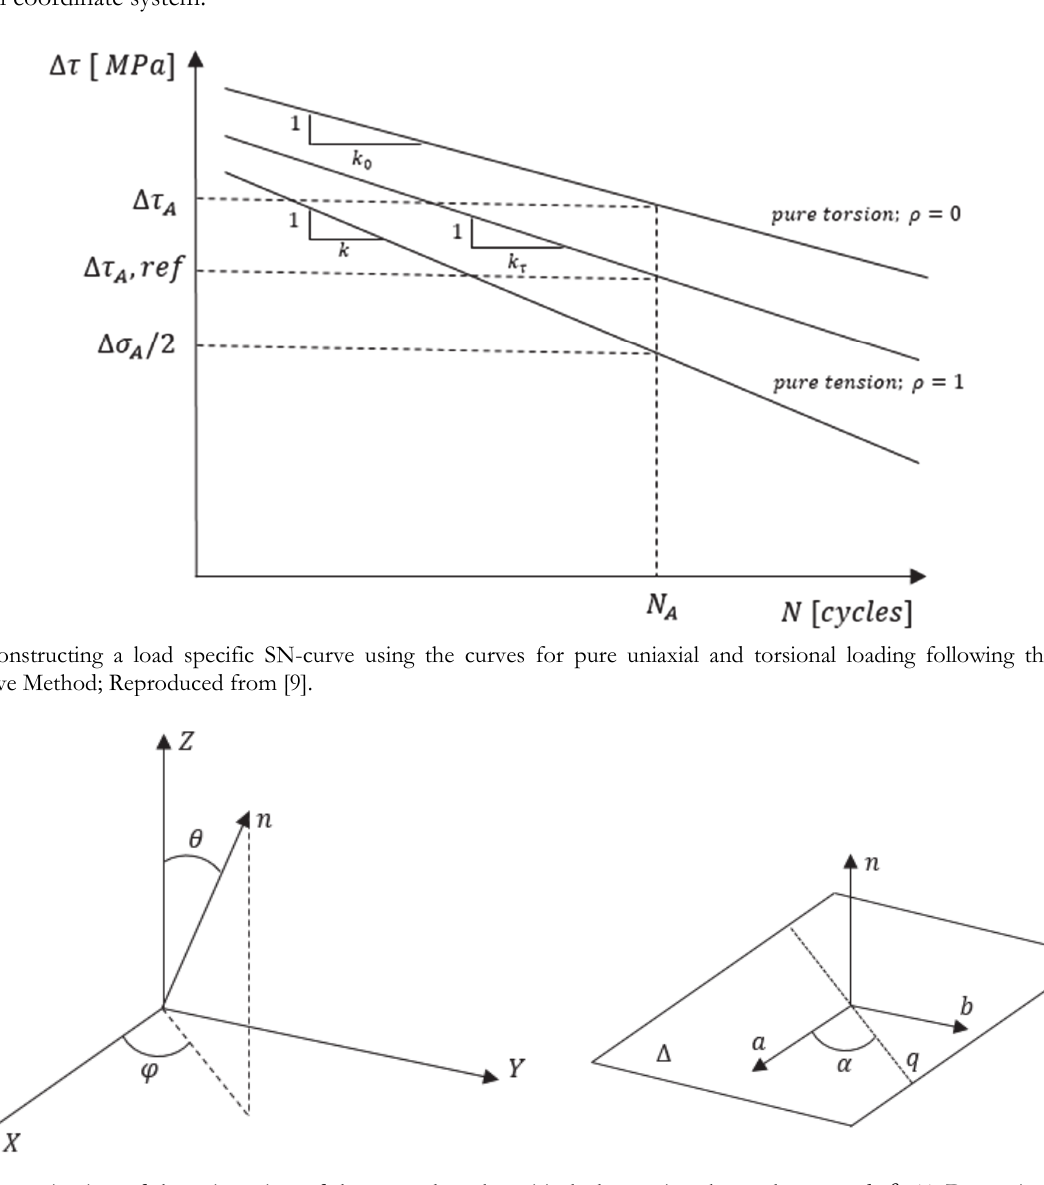
Figure 5: Determination of the orientation of the normal to the critical plane using the angles  and  (a) Determination of the orientation of the local coordinate system of the critical plane abn using angle  ; (b) Reproduced from